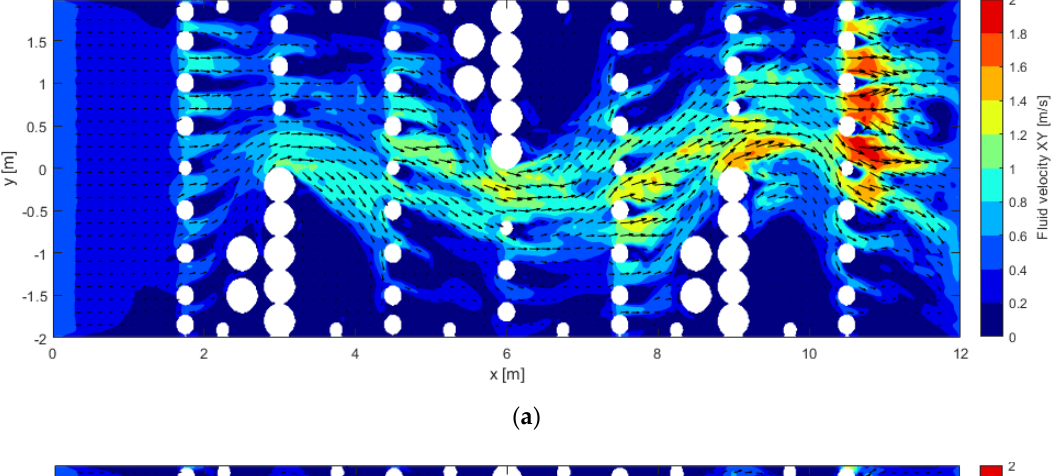
2 case ( a ) with smooth bed and ( b ) bed